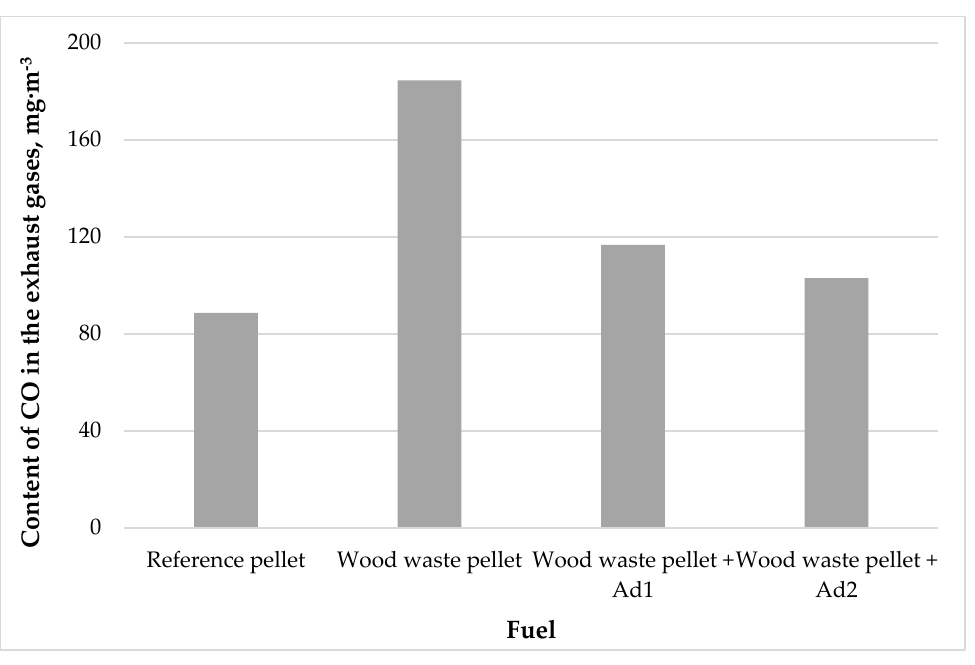
Figure 8. Carbon monoxide content in the exhaust gases during the combustion of fuels.